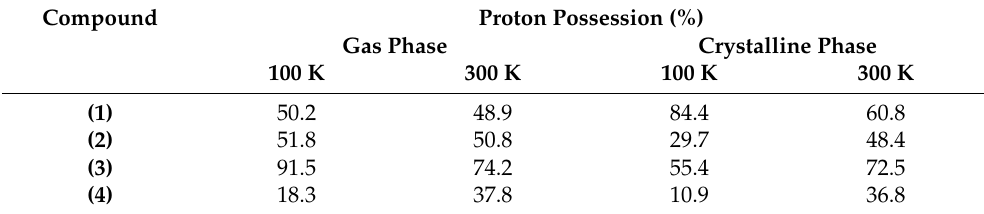
Table 2. Proton possession percentage during the CPMD simulation of the DMANH + and its derivatives. The reference nitrogen atoms are those at the position 1 of the aromatic system, i.e., the left amine functional group in Figure 1. The simulations were carried out using the PBE functional.